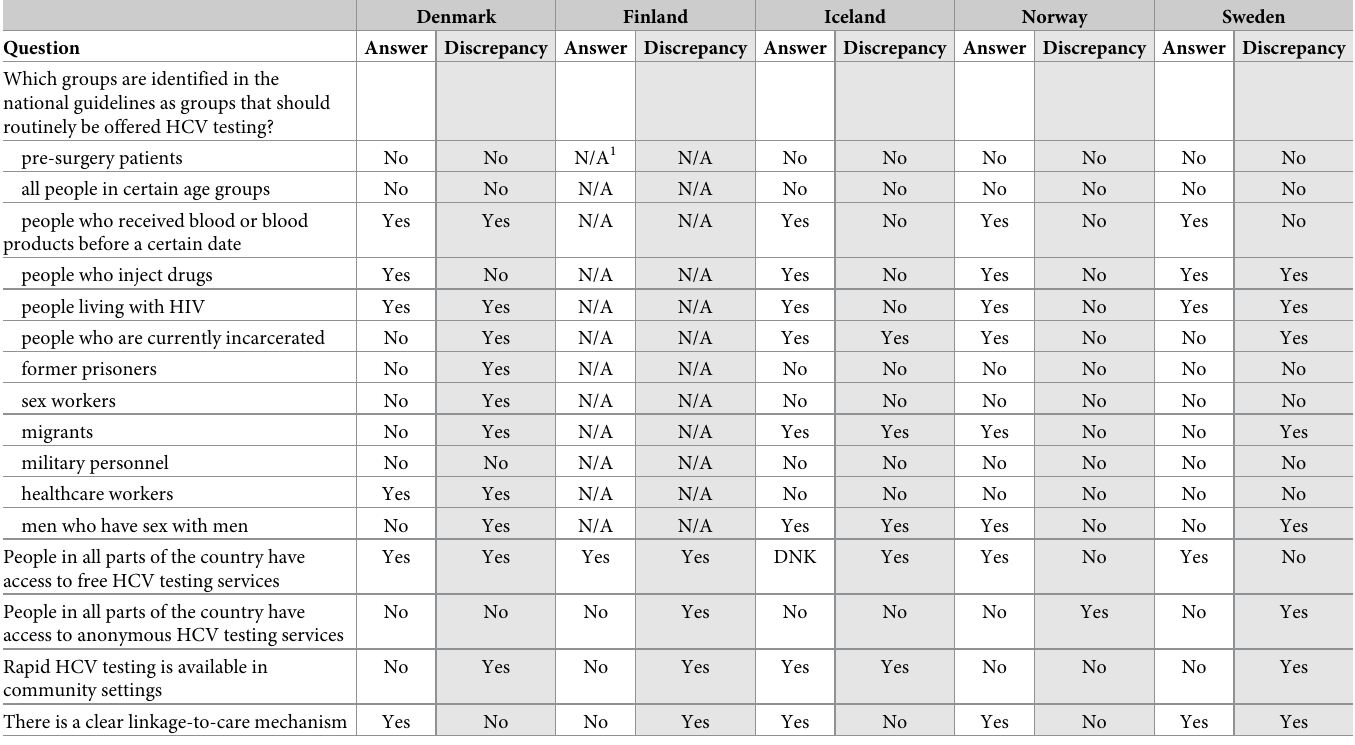
Table 3. HEPATITIS C TESTING AND LINKAGE TO CARE.